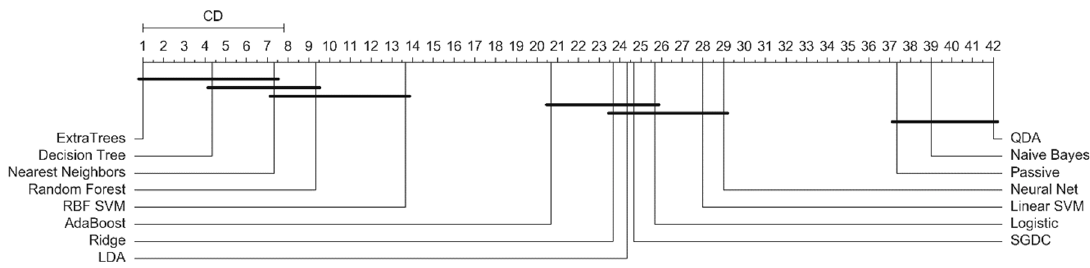
Figure 9. Comparison of mean ranks of final-stage classifiers based on their AUC performance.